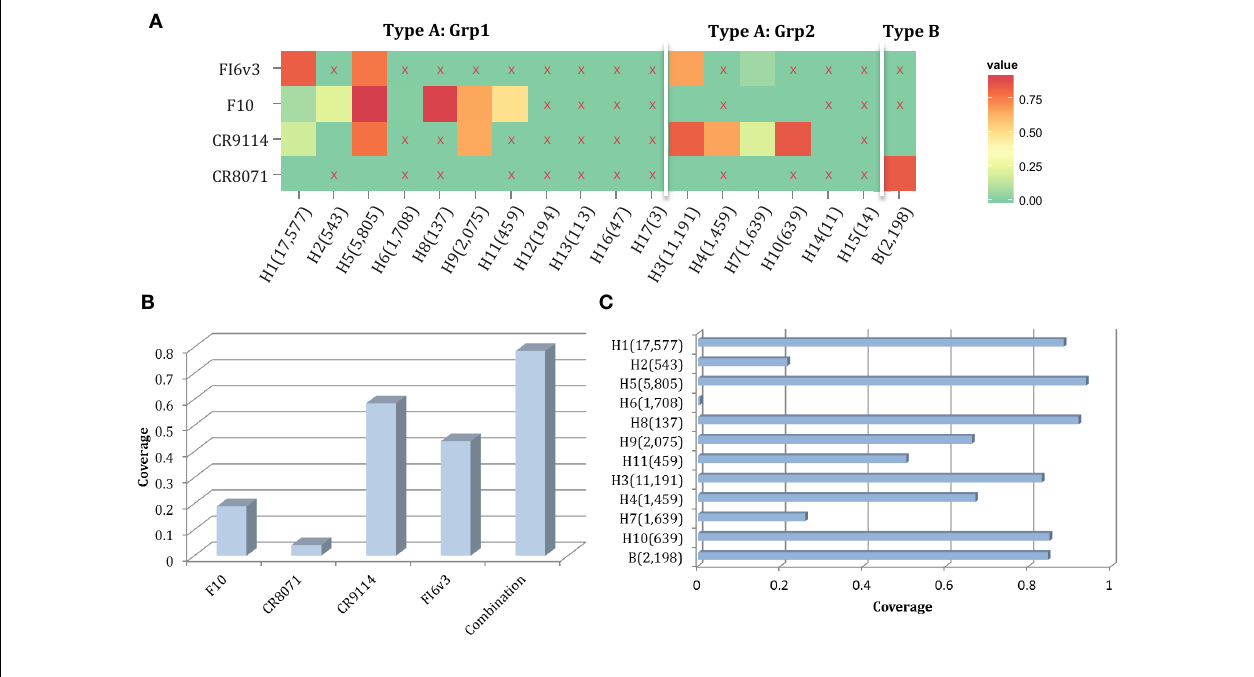
nAbs on HA dataset; and (C) the neutralizing result of combination of four nAbs by subtype.The subtypes were sorted from Grp1 and Grp2 in influenza A virus and influenza B virus. Only subtypes with neutralizing data are